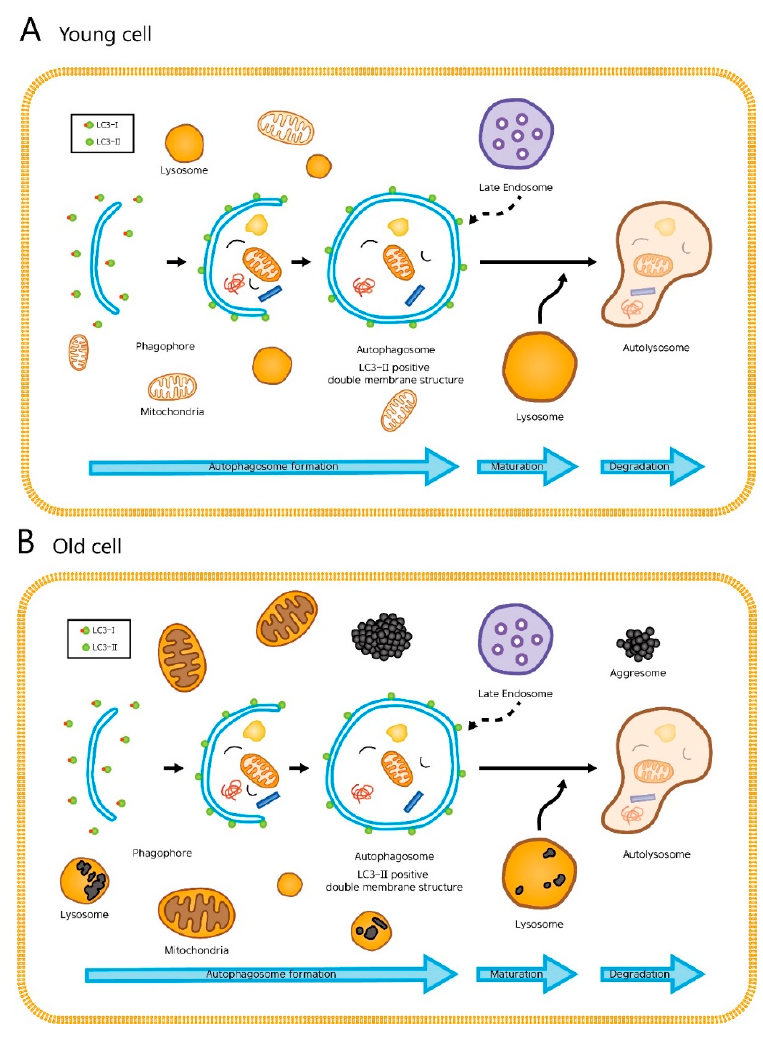
Figure 1 . The cellular processes during autophagy. The whole dynamic process of autophagosome formation, autophagosome maturation, and autophagosome degradation is termed the “autophagic flux”. ( A ) In young cells, autophagy efficiently degrades damaged mitochondria or cytosolic proteins. ( B ) In old cells, lipofuscin occupies the lysosome, which hampers autophagy. Enlarged mitochondria and cytosolic proteins in indigestible aggregates (aggresomes) are increased.